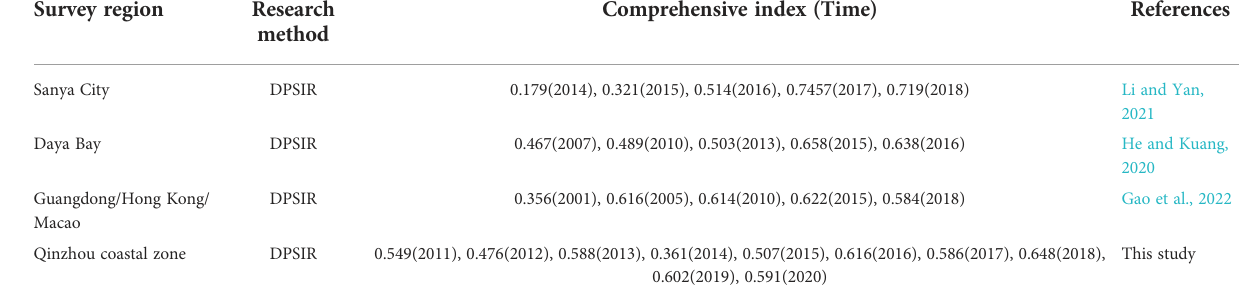
TABLE 6 Comprehensive index of Qinzhou coastal zone compared to other regions. Survey